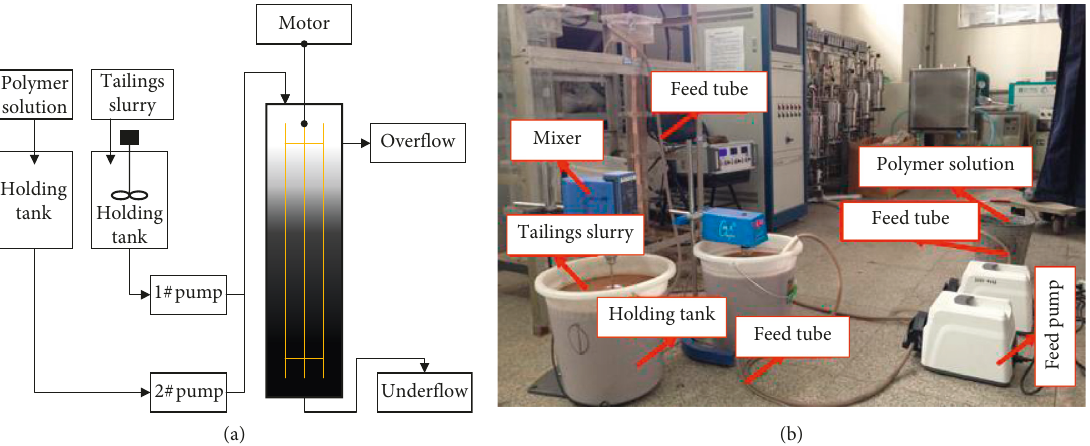
Figure 1: Pilot thickener test system.